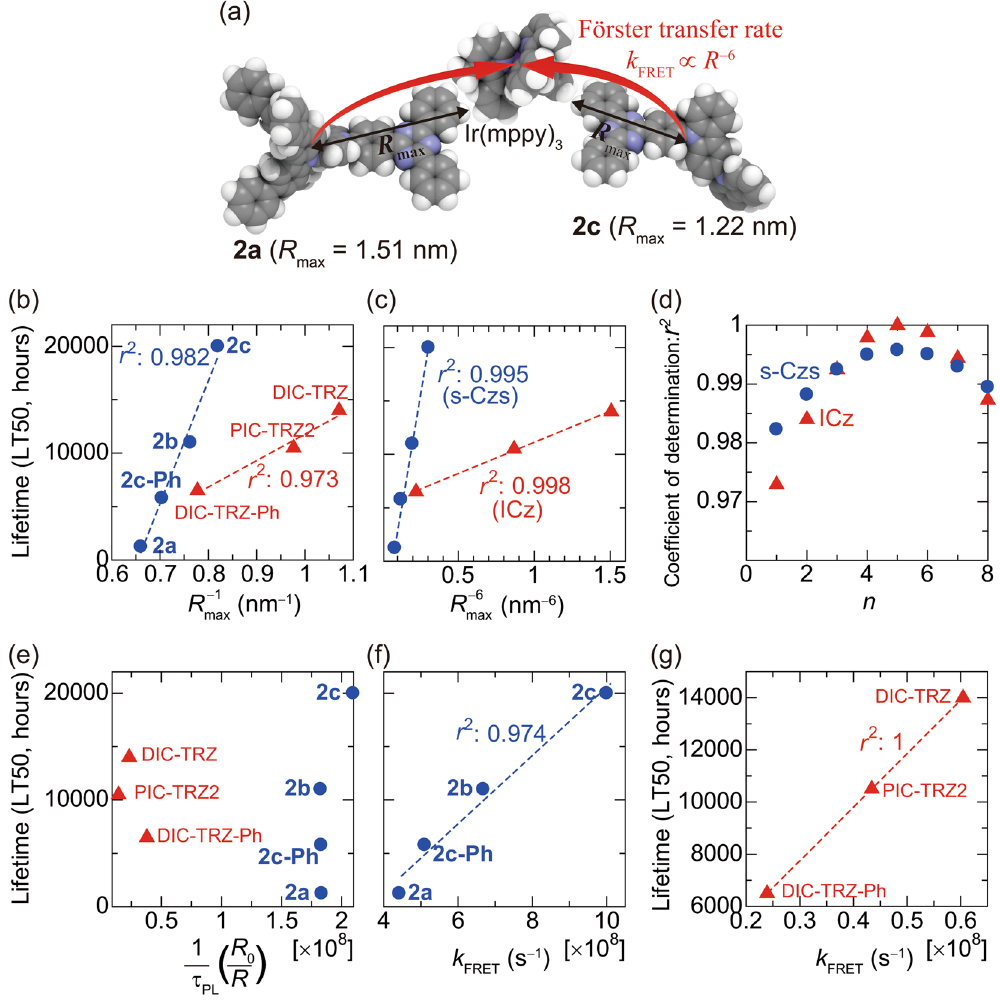
radius of host ( − R max1 ) and ( c ) − R max6 ; r 2 is the coefficient of determination for the linear approximation. ( d ) r 2 at each − R n as a function of a power index n . ( e ) PHOLED host-dependent lifetime versus 1/ τ PL × ( R 0 / R ). ( f , g ) max PHOLED host-dependent lifetime versus k FRET for the s-CZs host family ( f ) and the ICz host family ( g